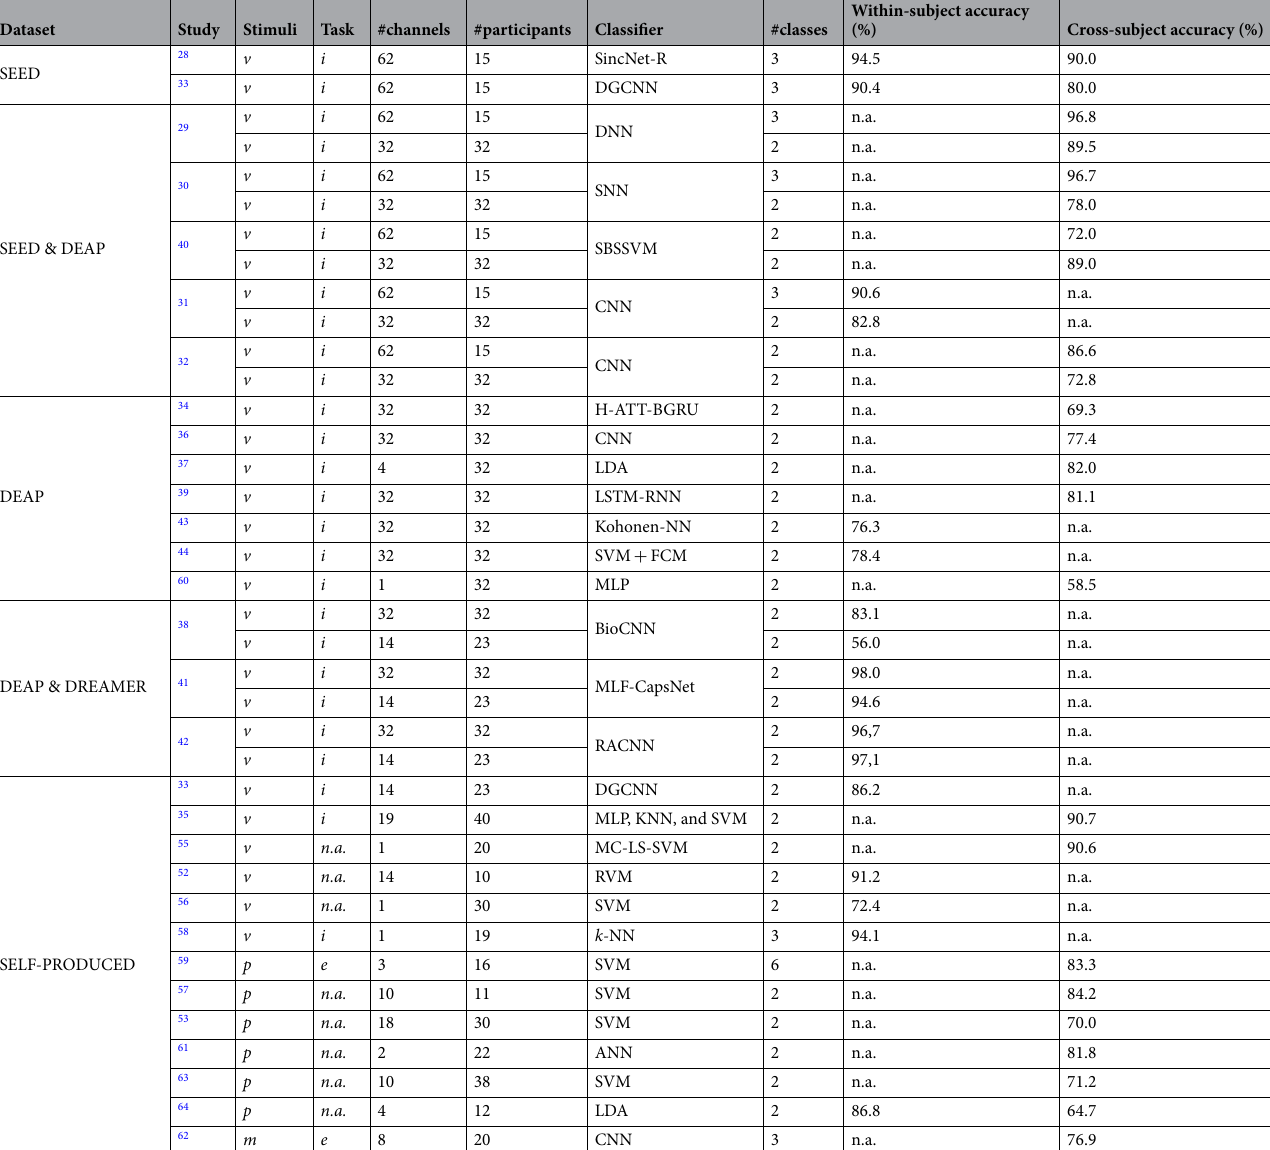
Table 1. Studies on emotion recognition classified according to the employed datasets (i.e. SEED, DEAP, and DREAMER), stimuli ( v ="video", p ="picture", m ="memories"), task ( i ="implicit", e ="explicit", n.a.="not available"), #channels, #participants, #classes, classifiers, and accuracies (n.a.="not